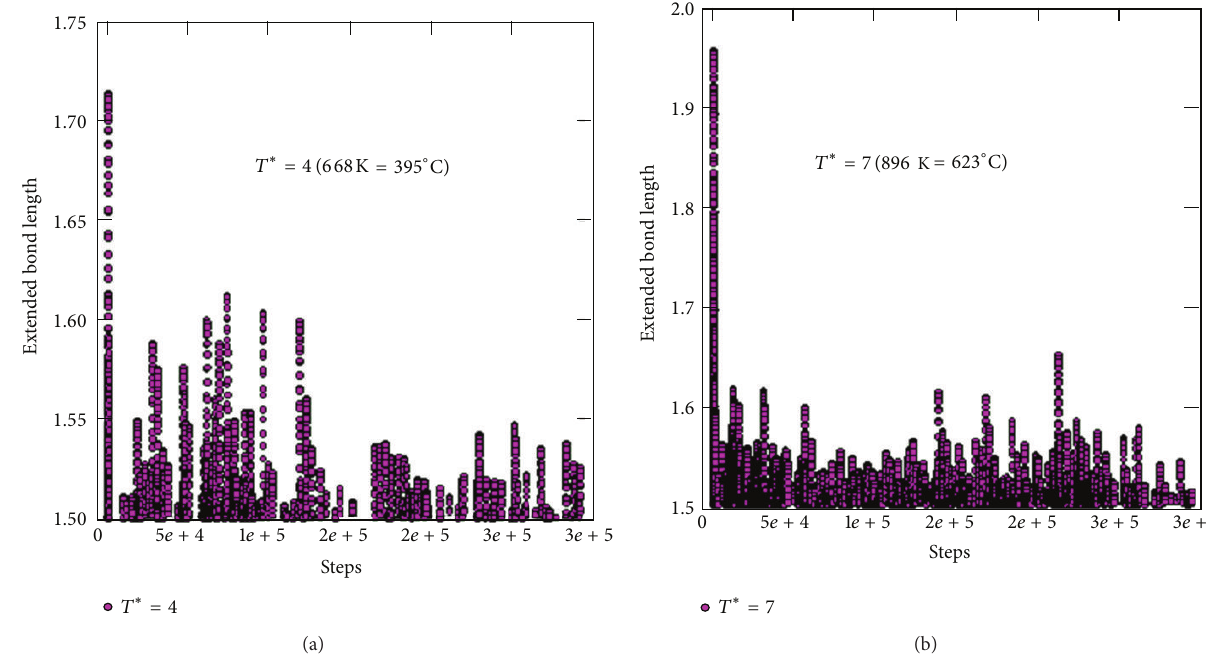
Figure 8: Extended bond length of PFPE Zdol at different temperatures: (a) 𝑇 ∗ = 4 (668K = 395 ∘ C) and (b) 𝑇 ∗ = 7 (896K = 623 ∘